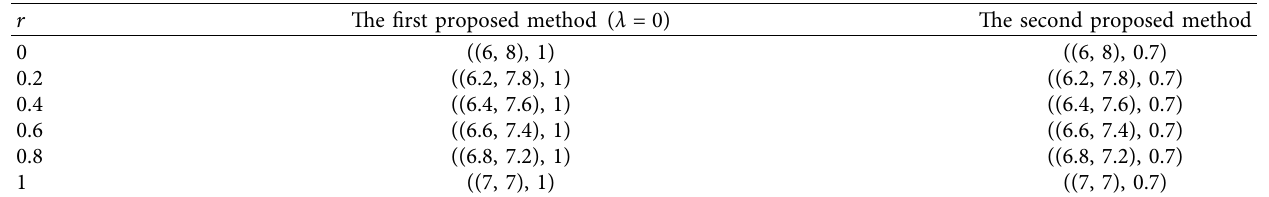
( r ) result using the two proposed methods ( λ � 0 ) 3